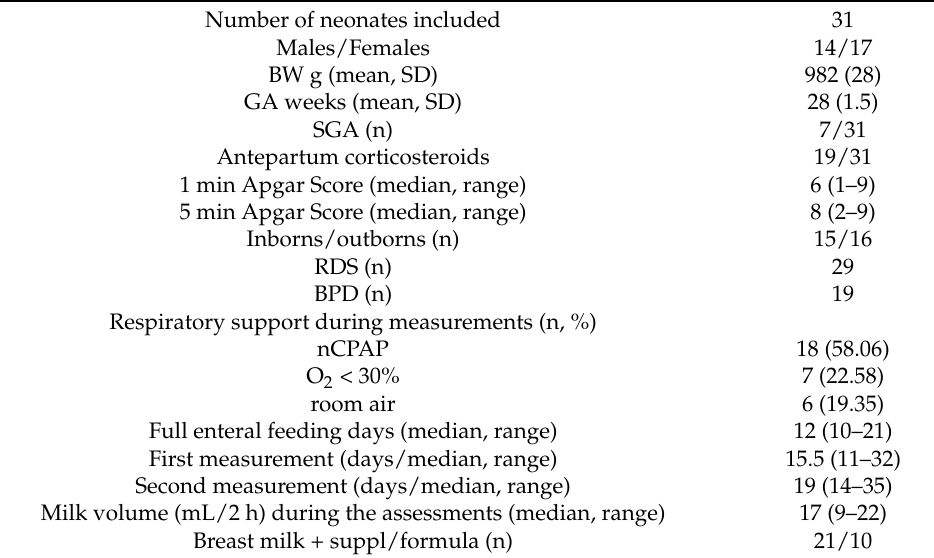
Table 1. Baseline characteristics of the neonates